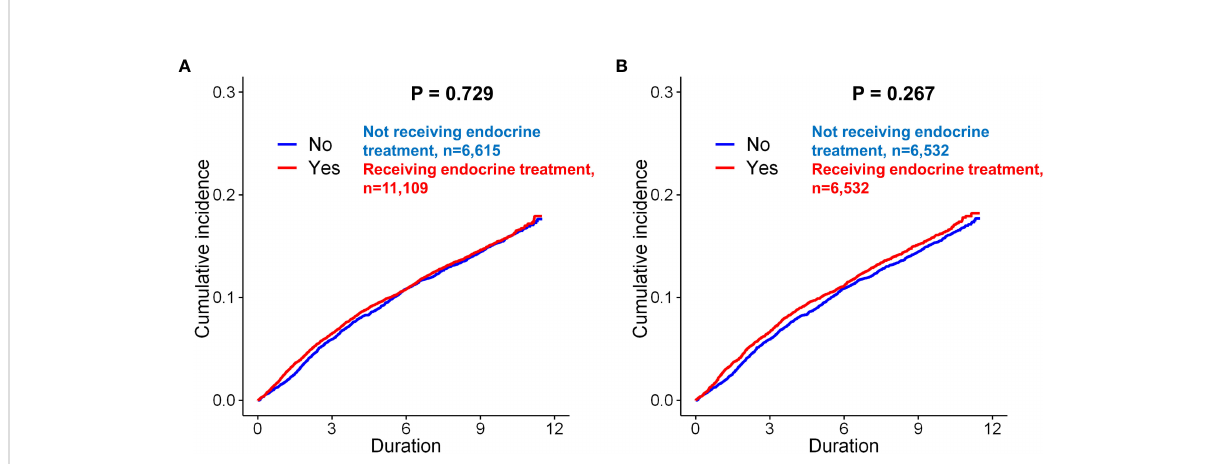
FIGURE 2 Kaplan – Meier analysis of the incidence of depression in breast cancer patients according to endocrine treatment. Before matching, there was no signi fi cant difference between the patients who underwent endocrine treatment and those who did not undergo endocrine treatment (A , p = 0.729, log-rank test ) . After matching, there was still no signi fi cant difference between the two groups of patients (B , p = 0.267 )